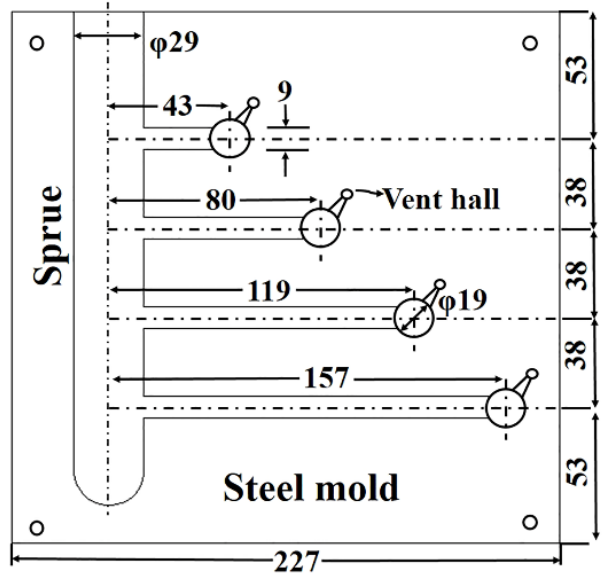
Figure 1. Shrink rod mold for a hot tearing experiment. Among them, f crack f length and f location , respectively, represent the size of the crack, the length of the test bar where the crack occurs, and the location where the crack occurs on the test bar. When the value of f crack is 1, the crack is hairline, 2 represents the crack is hairline, and 3 represents the crack for severe cracks, 4 represents complete fracture; f length value 4 represents the longest hot tearing rod, 8 represents the second-longest hot tearing rod, 16 represents the second shortest hot tearing rod, and 32 represents the shortest hot tearing rod; f location value 1 represents that the fracture occurred at the gate, a value of 2 represents that it occurred at the constrained ball position, and a value of 3 represents that the fracture occurred at the middle of the hot tearing